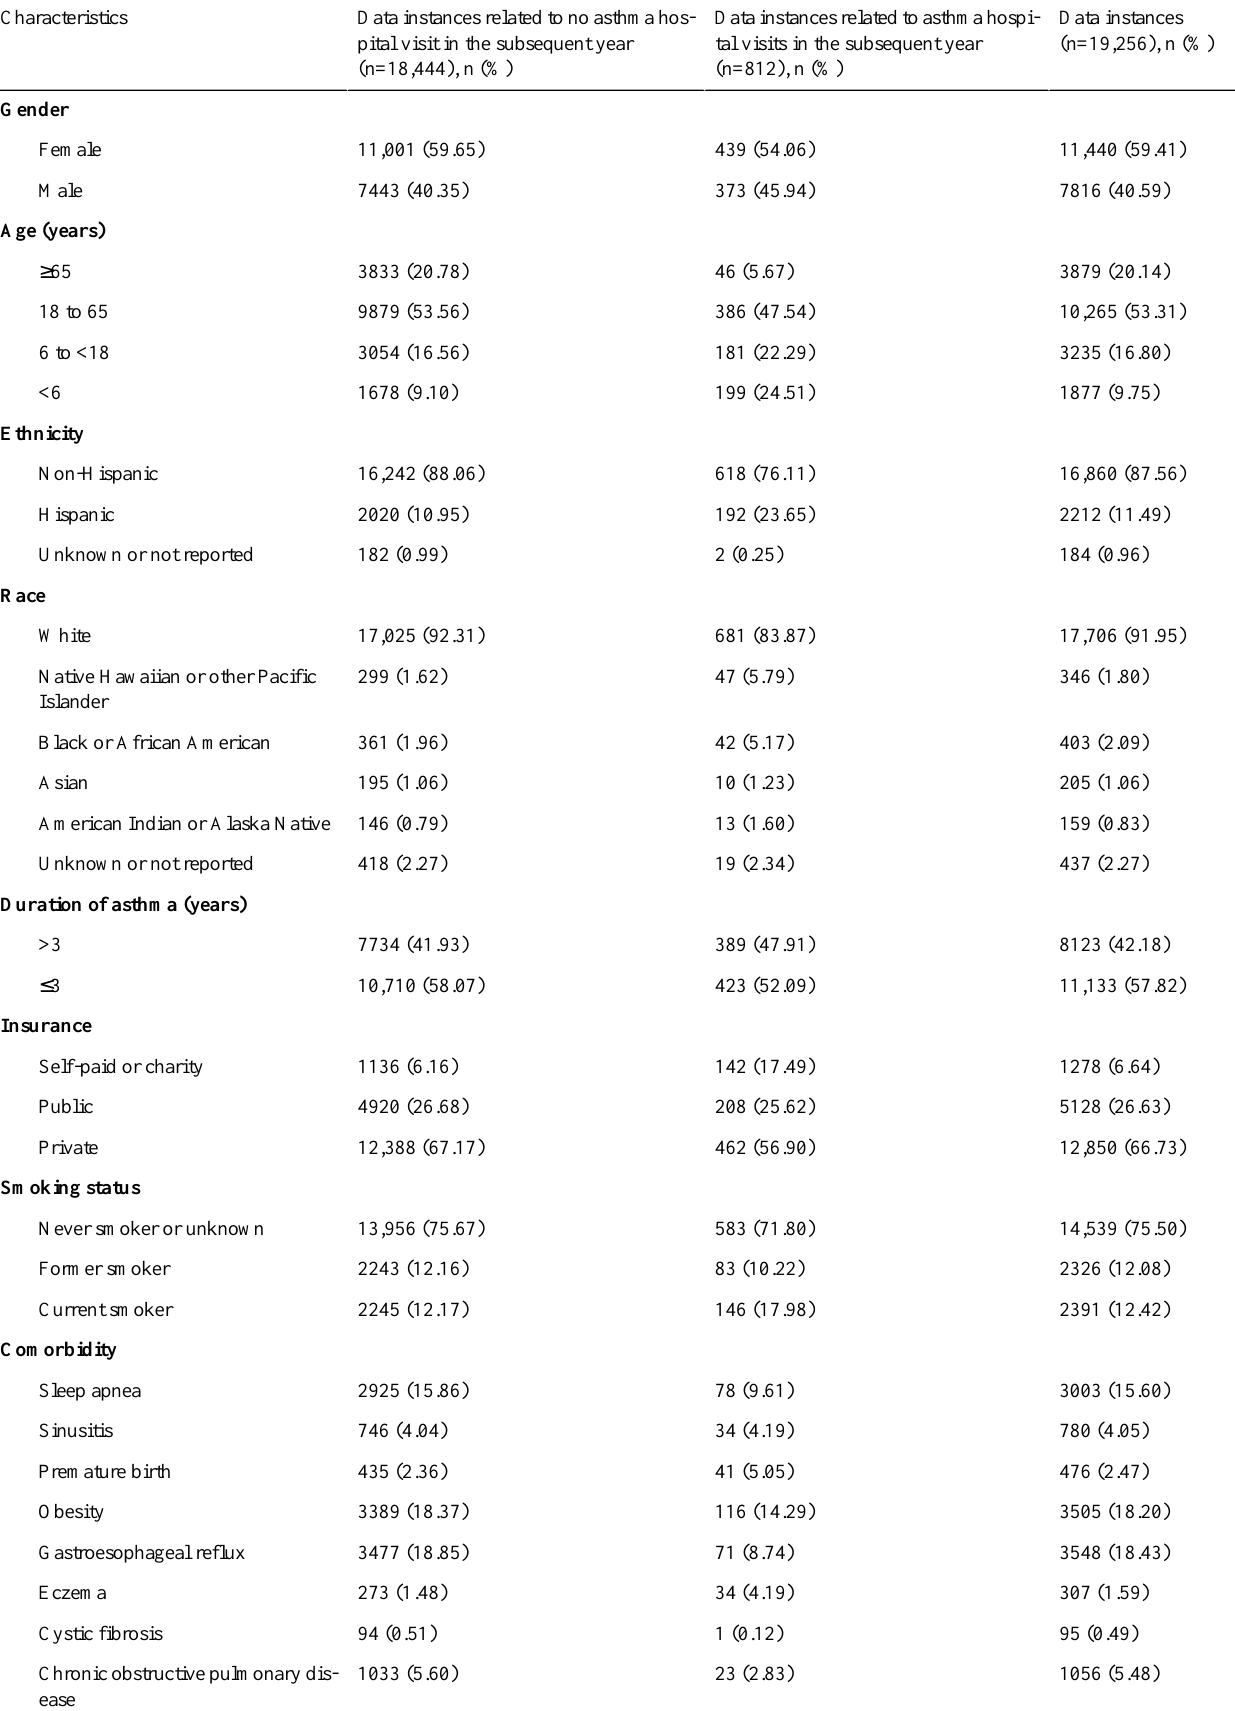
Table 2. Demographic and clinical characteristics of the Intermountain Healthcare patients with asthma in